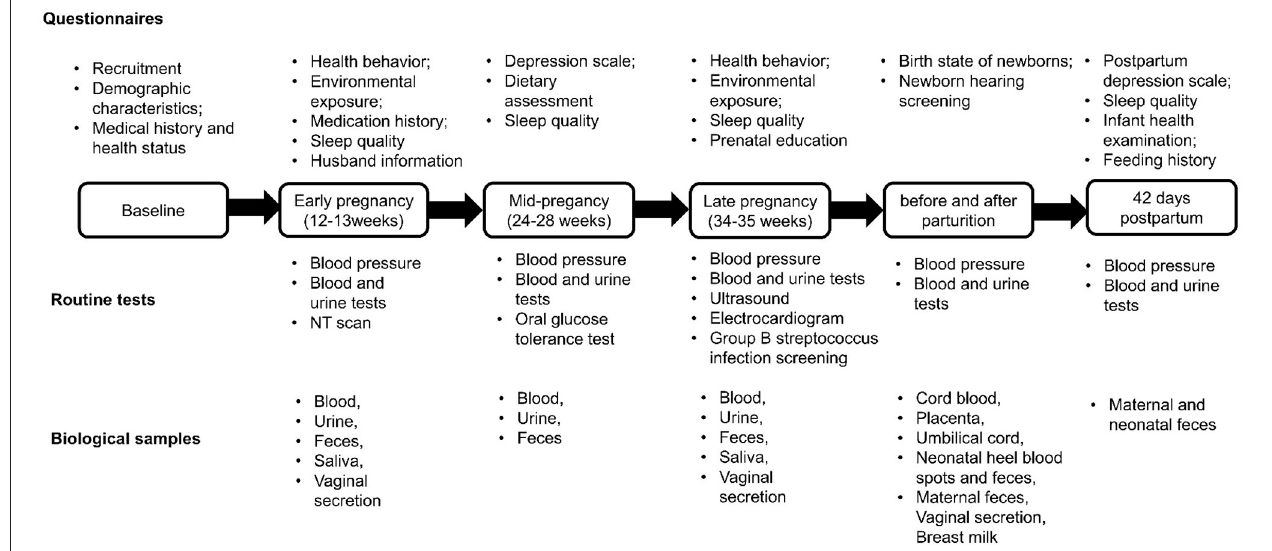
FIGURE 1 | Questionnaires, routine tests and biological samples were collected at different time points in the CHALLENGE birth cohort. Six types of questionnaires including baseline information, environmental exposures, physical exercise sleep quality, depression scale, and dietary information were collected. After the baseline information was collected, routine tests were conducted in 5 follow-up visits including three routine prenatal testing at 12–13 weeks, 24–28 weeks and 34–35 weeks, one postpartum checkup, and one postnatal checkup at 42 days after parturition. During these visits, blood pressure, blood tests, urine tests and additional tests